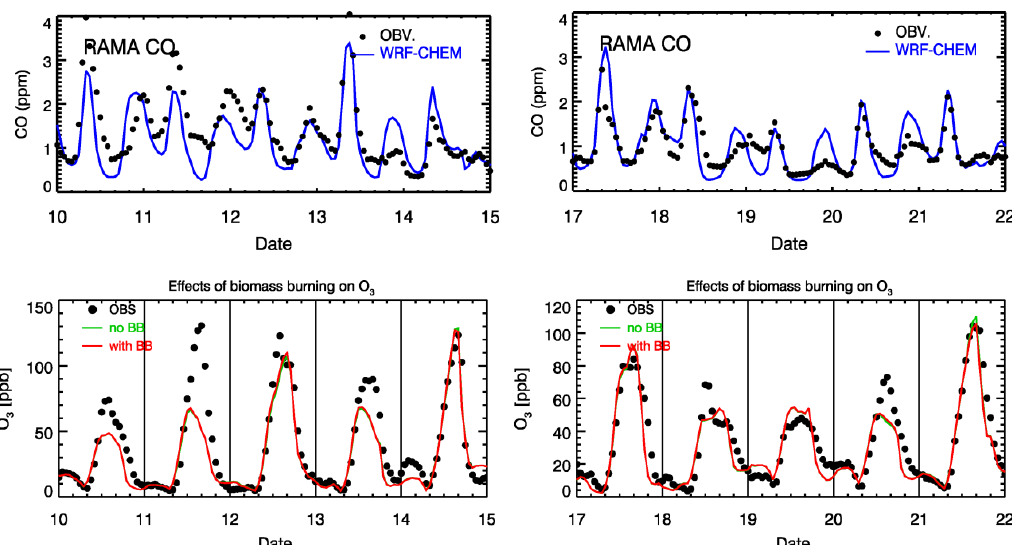
Fig. 4. Comparisons of measured and simulated CO and O 3 averaged over the RAMA stations during 10–14 and 17–21 March 2006. Dots represent observations, and lines represent simulations. Two cases for O 3 simulations are presented: excluding BB (no BB, green lines) and including BB (with BB, red lines) emissions. Note that because of the small impact of BB on O 3 , the green and red lines are almost overlapped most of the time.